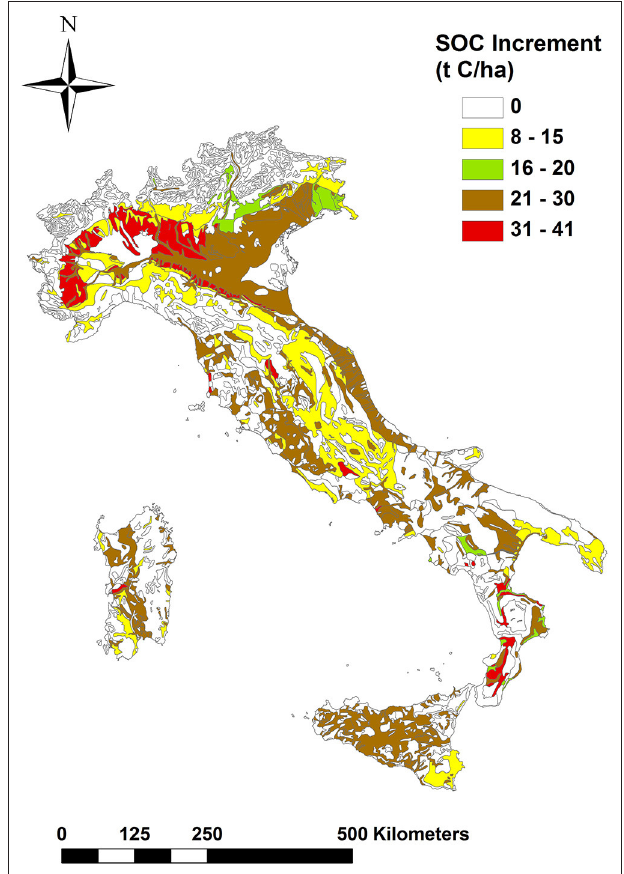
FIGURE 7 | Map of modeled increase in soil organic C (SOC, t ha − 1 ) after 100 years of compost addition (1.0t C ha − 1 y − 1 ) to Italian arable soils (climate scenario PCM B1). The increase in SOC refers to the business as usual scenario in 2100.